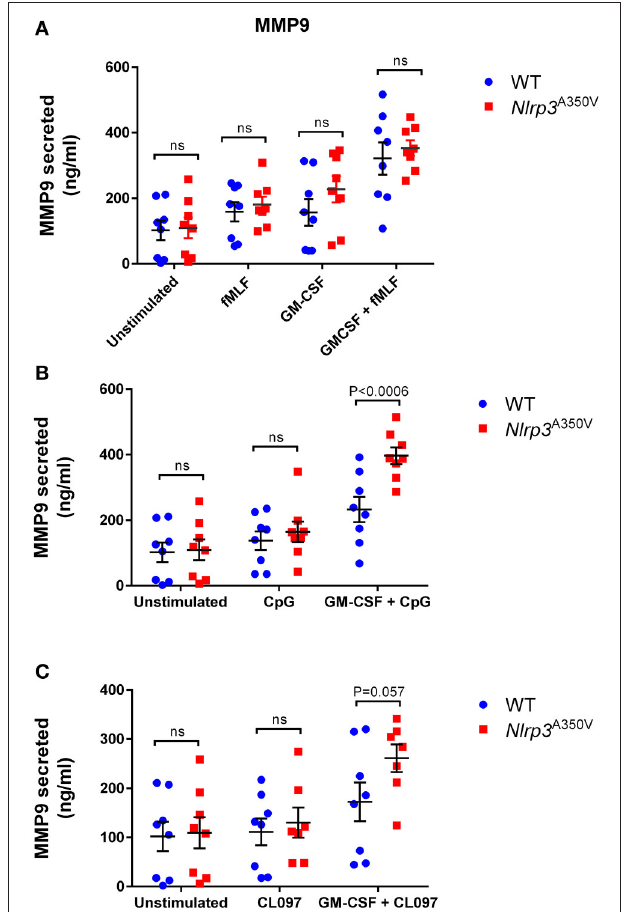
FIGURE 2 | Effect of the Nlrp3 A350V mutation on gelatinase granule exocytosis in neutrophils. (A–C) , The mobilization of gelatinase granules was analyzed by monitoring the secretion of gelatinase B (MMP-9) by ELISA as described under “Materials and Methods.” Wild type (WT: blue) or MWS neutrophils (Nlrp3 mutant: red) were treated with GM-CSF or vehicle for 30min and subsequently stimulated with the indicated agonists as described under “Materials and Methods.” Each symbol corresponds to an individual mouse and the error bars indicate mean ± SEM of 8 independent mice from 3 independent experiments. Significant differences between groups were calculated using ANOVA followed by Fisher’s post-hoc test. ns, not